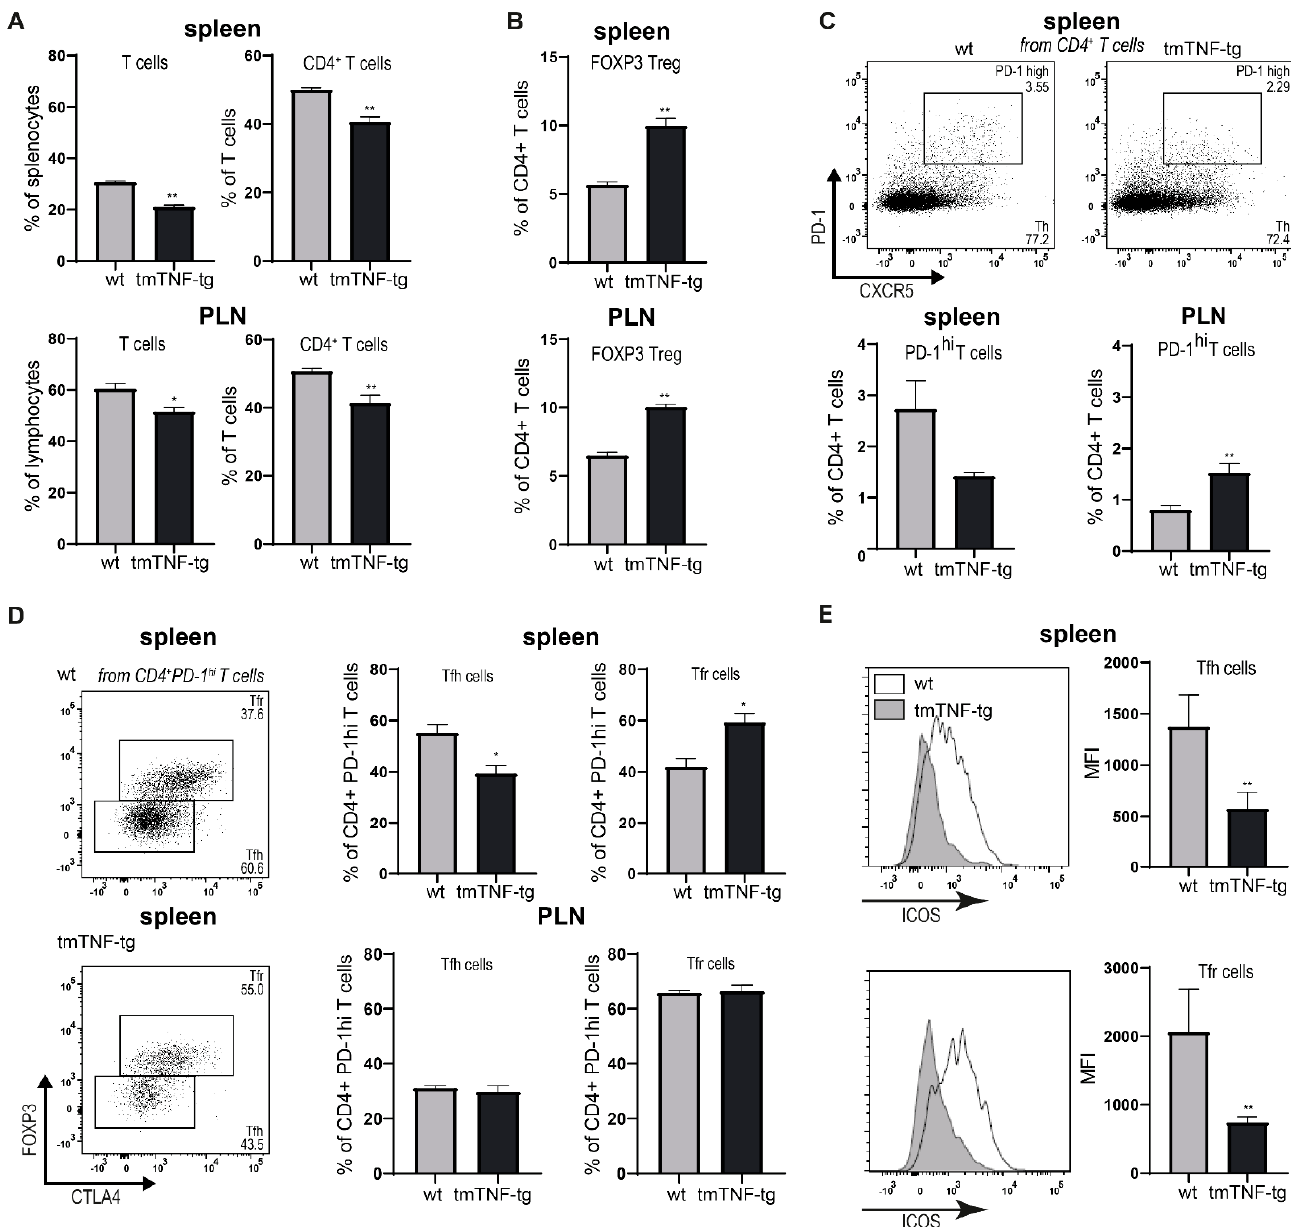
Figure 4. The spleen of tmTNF-tg mice has aberrant proportions of germinal center-associated T cell populations. Different GC T cell populations were analyzed by flow cytometry. ( A ) Decrease in total T cell and CD4 + fractions in spleen and PLN of tmTNF-tg mice. ( B ) Increase in the fraction of FOXp3 Treg cells in the spleen and PLN of tmTNF-tg mice. ( C ) Representative dot plots showing the gating strategy to separate PD-1 high T cells (from CD3 + CD4 + populations). PD-1 high T cell proportions were decreased in the spleen and increased in PLNs of tmTNF-tg mice. ( D ) Representative dot plots showing the gating strategy to separate FOXP3 + CTLA4 + Tfr cells from FOXP3 − CTLA4 − Tfr cells (from PD-1 high populations). ( E ) The Tfh cell proportion decreased and Tfr cell proportion increased in the spleen of tmTNF-tg mice. No changes were found in PLN of tmTNF-tg mice compared to wt mice. GC = germinal center; Treg = regulatory T cell; Tfr = T follicular regulatory cells; Tfh = T follicular helper cell; * = p ≤ 0.05; ** = p ≤ 0.01; n = 6 for all graphs. As a measure of potential B cell costimulatory properties, we measured ICOS [18] expression and found that both Tfh and Tfr cells in the spleen of tmTNF-tg mice had a strong reduction of ICOS expression compared to wt mice (Figure 4E).